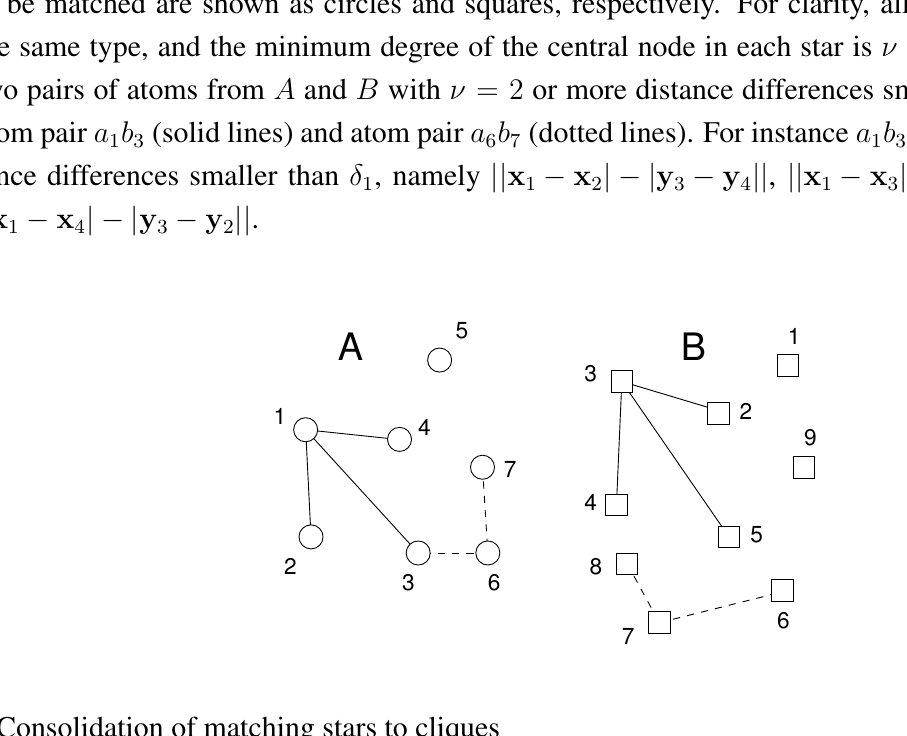
: 1 b has three 1 3